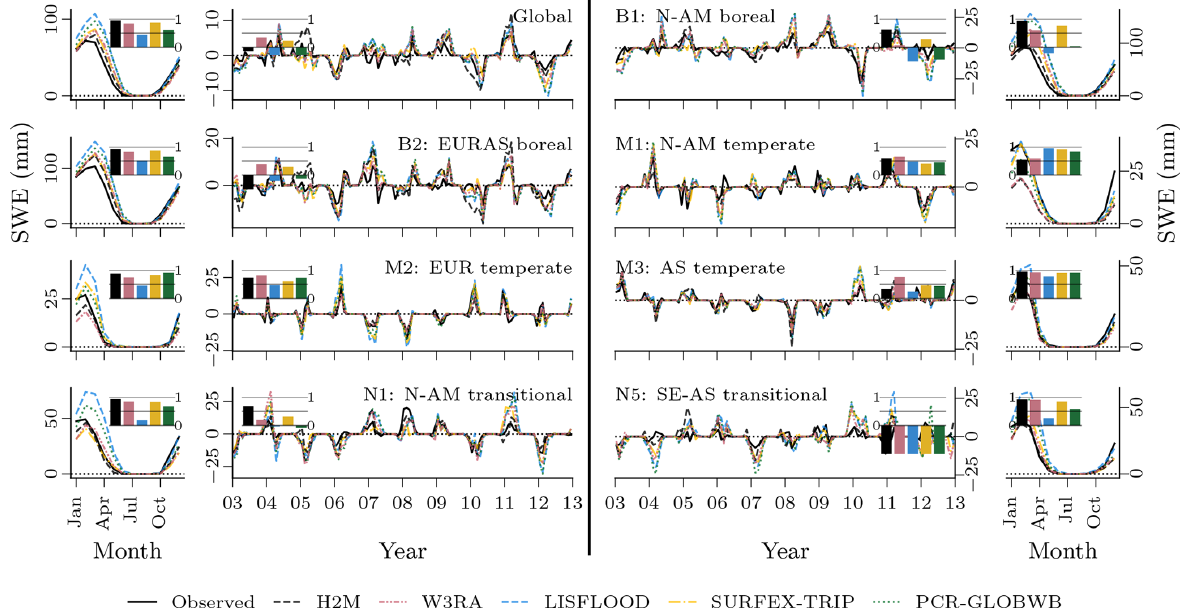
Figure B2. Comparison of the hybrid hydrological model (H2M) and a set of process-based global hydrological models (GHMs) of the snow water equivalent mean seasonal cycle (SWE MSC ; outer columns) and interannual variability (SWE IAV ; center columns) in millimeters for hydro-climatic regions (Fig. 2). The time series were aggregated using the cell-size-weighted mean across all grid cells in the respective region. The inset axes show the Nash–Sutcliffe model efficiency (NSE) of each model with the same color-coding as the time series. Note that regions without snow dynamics are not included. The y scale differs between